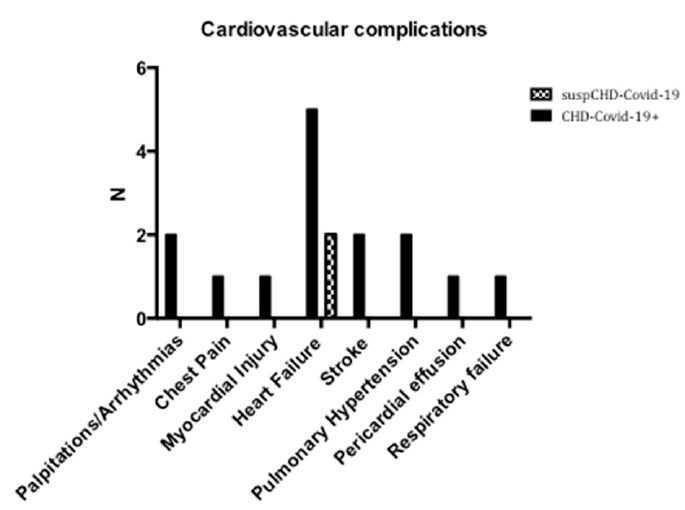
Figure 2. Cardiovascular complications of patients with congenital heart disease and CHD-Covid-19+ (confirmed diagnosis of COVID-19) or suspCHD-Covid-19 (clinically suspected COVID-19). N = number of cases. Table 2. Characteristics of 9 patients with Congenital Heart Disease infected with COVID-19. Patients Characteristics